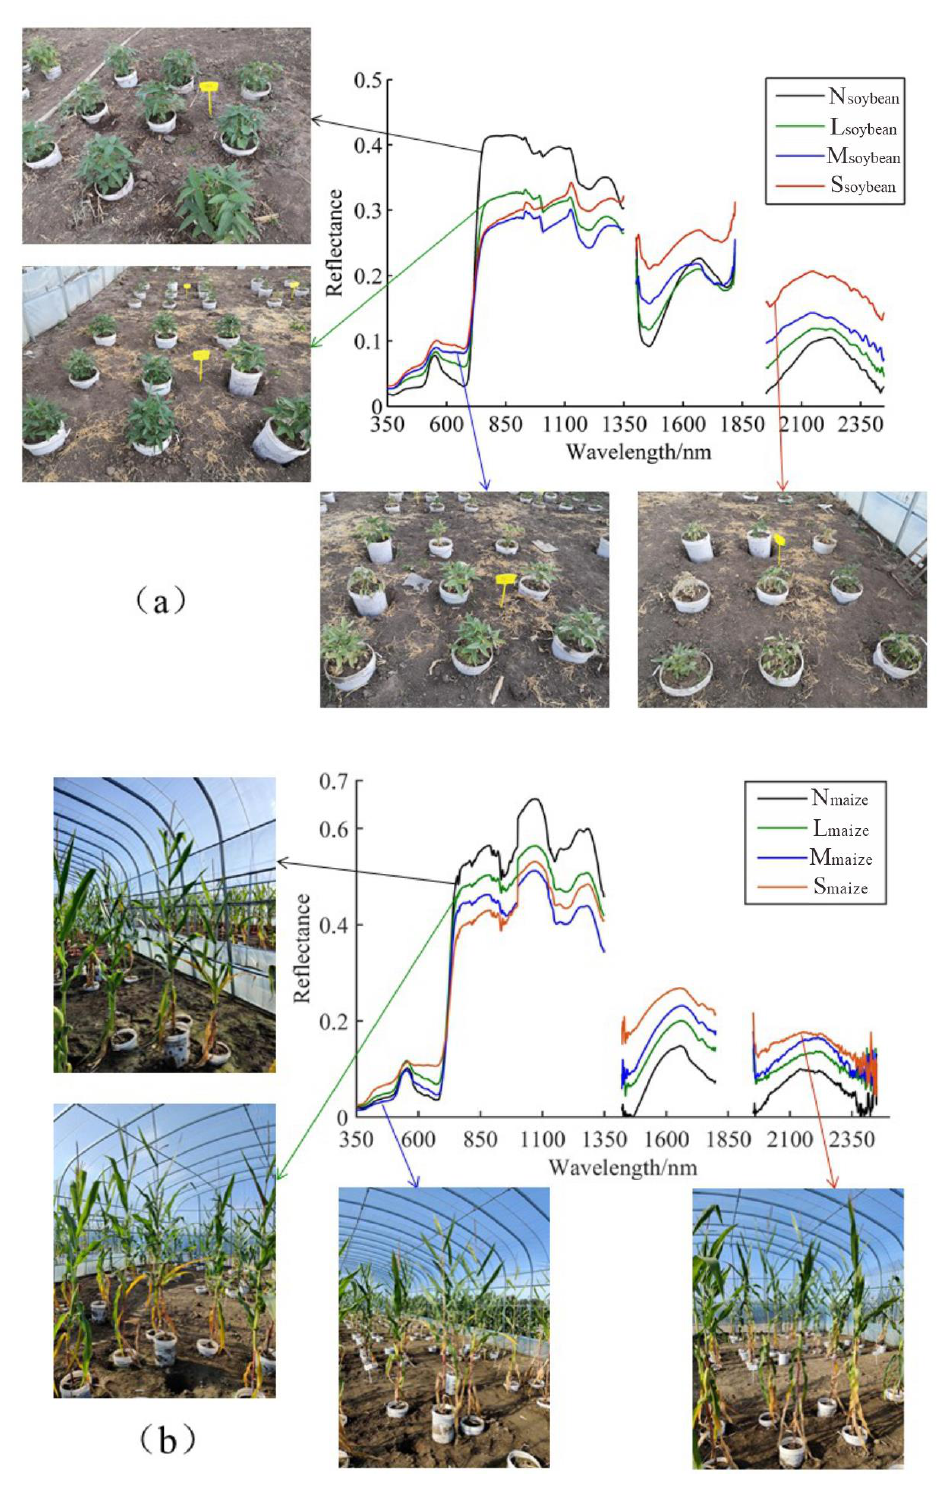
Figure 4. Spectral reflectance of crop canopy at different water stress levels. ( a ) Canopy spectral reflectance of soybean at the branching stage and experimental photographs; and ( b ) canopy spectral reflectance of maize at the milking stage and experimental photographs (the missing parts of spectral reflectance are the atmospheric water vapor absorption channel during field measurement).